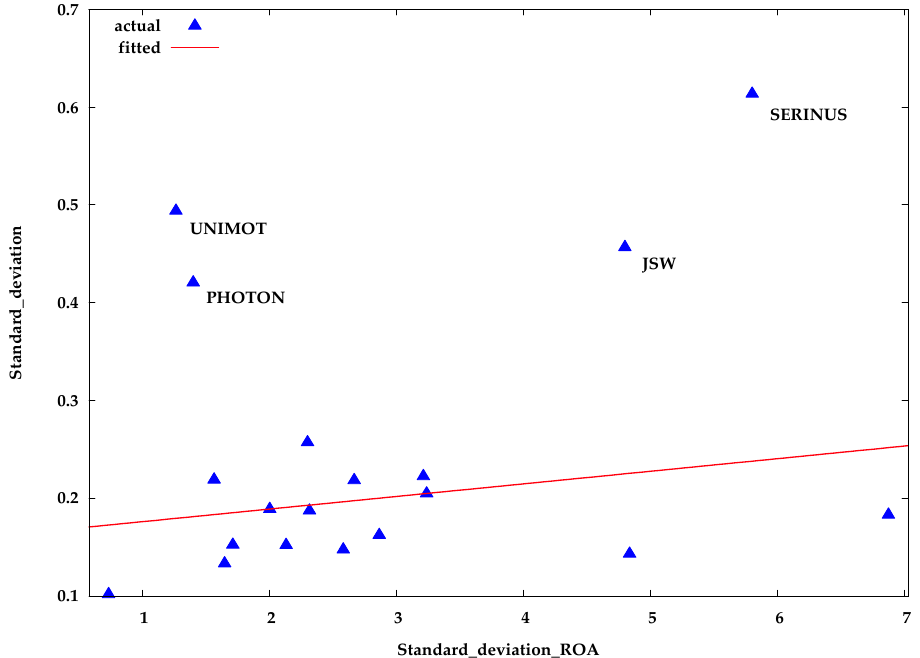
Figure 1. Quantile regression line for the standard deviation of returns vs. standard deviation for ROA ( τ = 0.5 ).